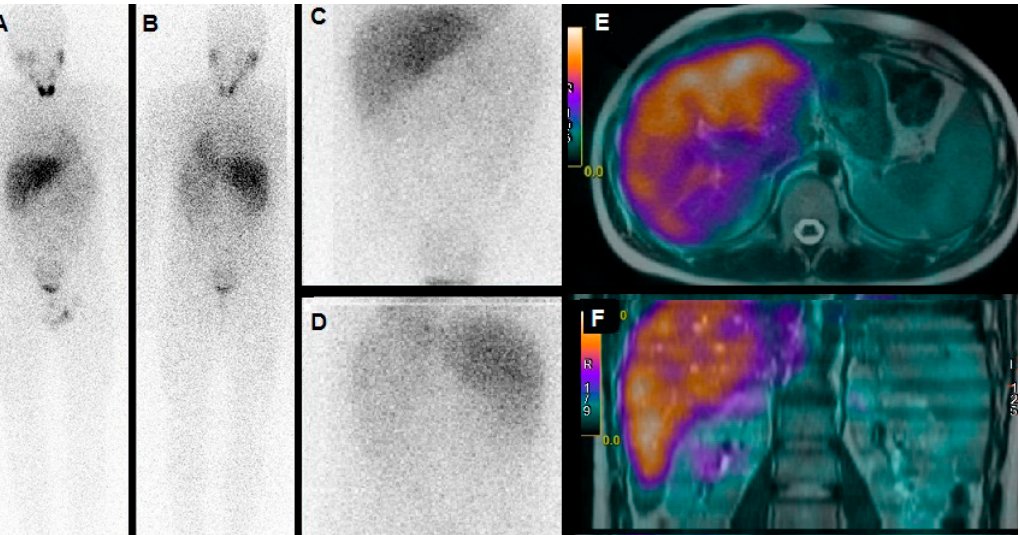
Figure 2. A 13-year-old boy suffering from hypertension, with evidence of slightly increased levels of catecholamine metabolites in urine. 123 I-MIBG scintigraphy was carried out for the suspicion of pheochromocytoma. Whole Body scan in anterior ( A ) and posterior ( B ), abdominal planar ( C , anterior; D , posterior) did not show any area of abnormal tracer uptake. Co-registered corresponding axial ( E ) and coronal ( F ) SPECT/MRI images confirmed the absence of pathological hyperactive masses in both adrenal glands.